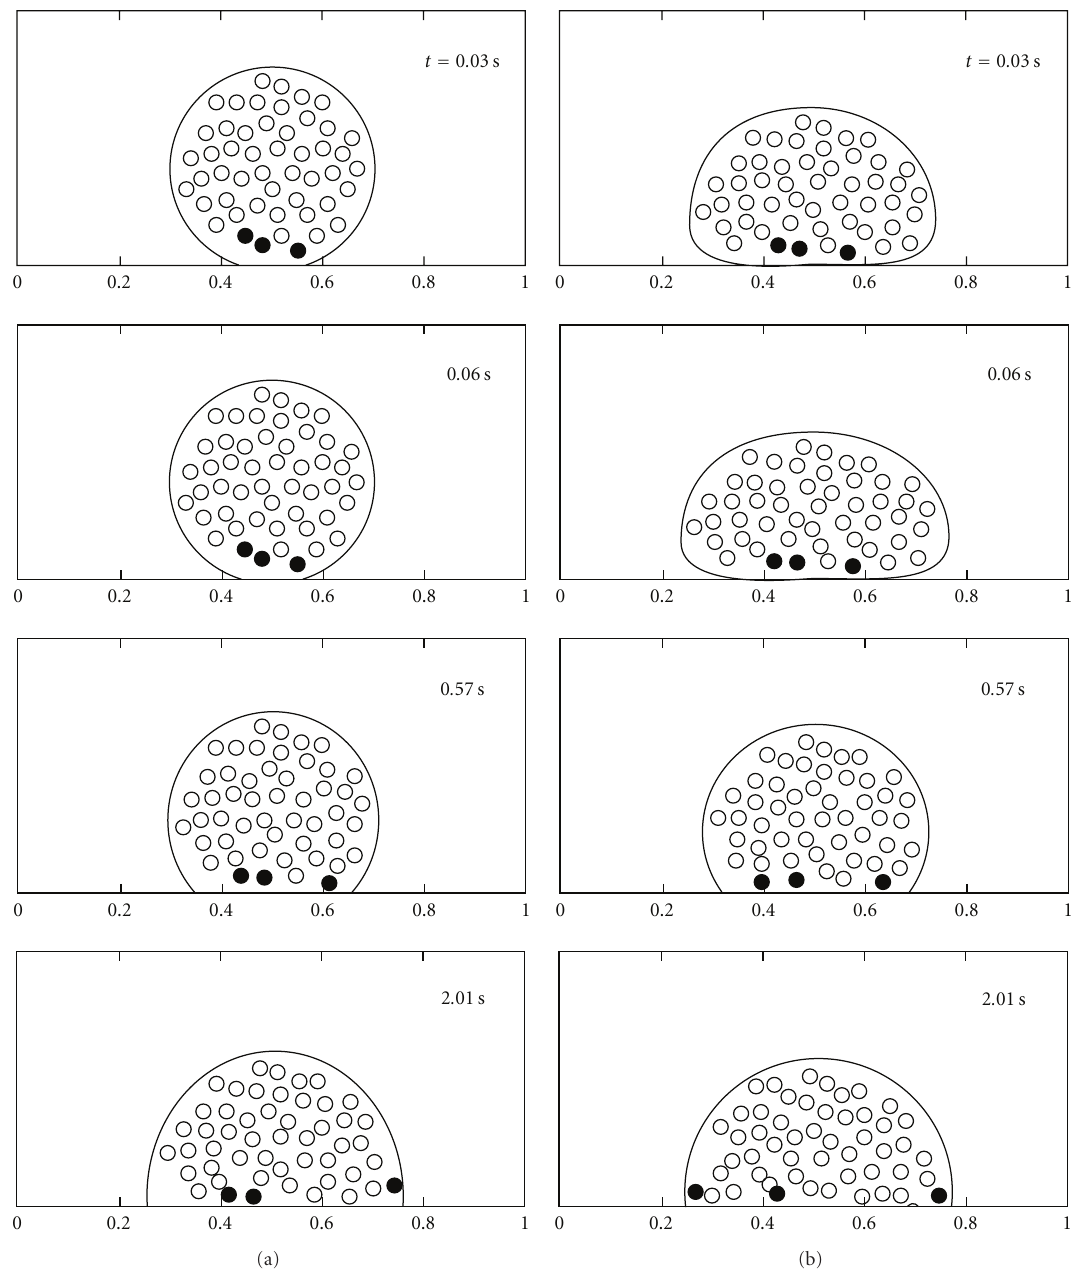
Figure 5: The consecutive drop deformation shapes with particle distributions (a) for the capillary spreading and (b) the inertial impact